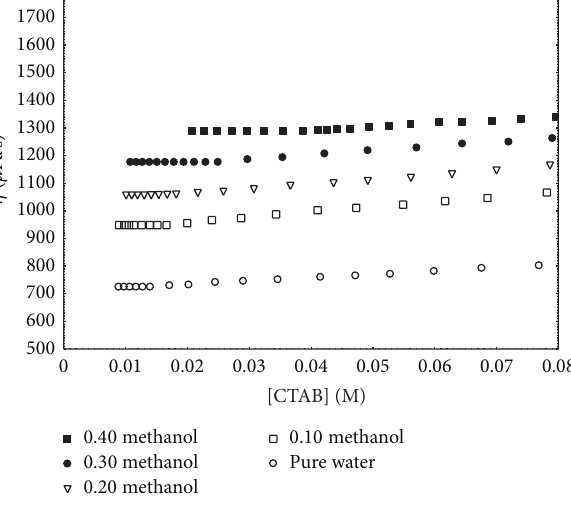
Figure 4: Viscosity versus concentration of CTAB solution at 298.15 K.